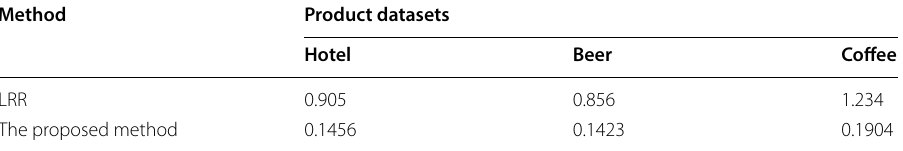
Table 7 MSE of overall rating prediction